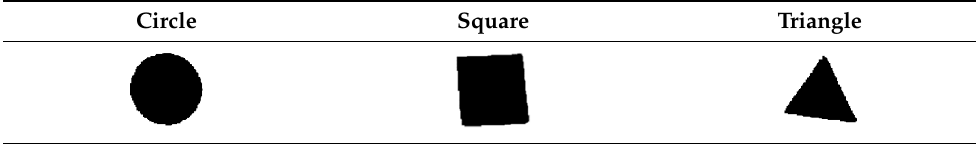
Table 3. Examples from the basic form data set. Circle Circle Square Triangle Circle Square